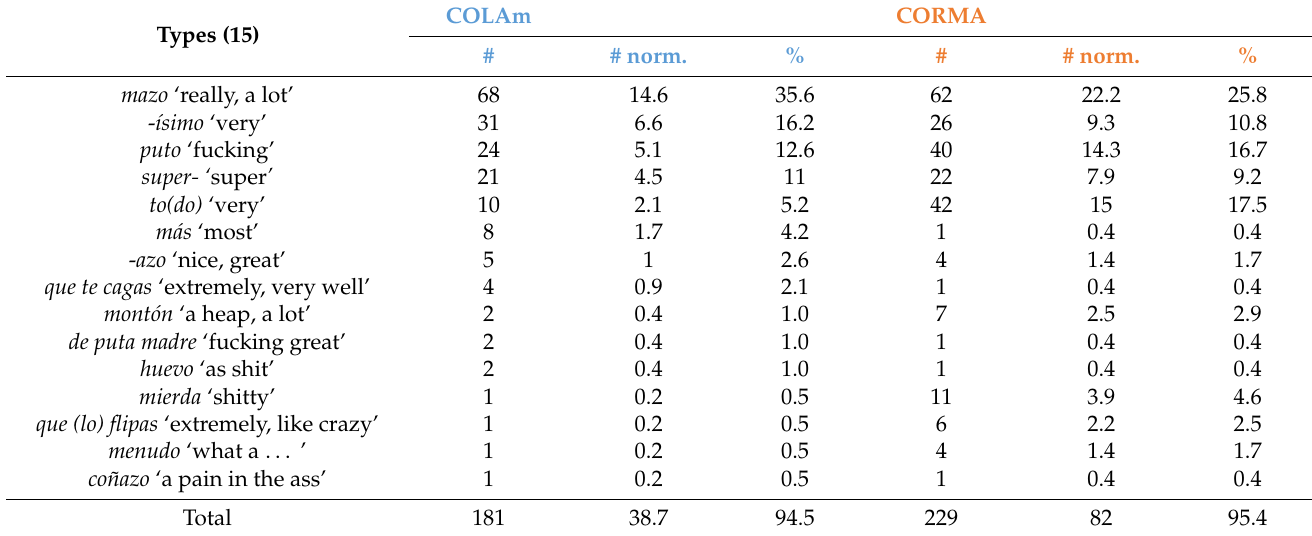
Table 4. Comparison of intensifier types occurring in both COLAm and